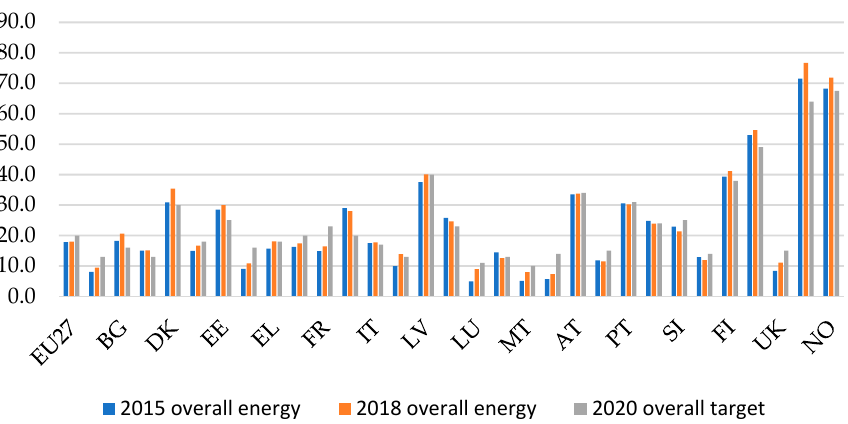
Figure 1. Overall energy consumption from renewable sources in Europe in 2015, 2018, and 2020 (target value). Source: Based on https://ec.europa.eu/eurostat/web/energy/data/shares (accessed on 25 October 2021).